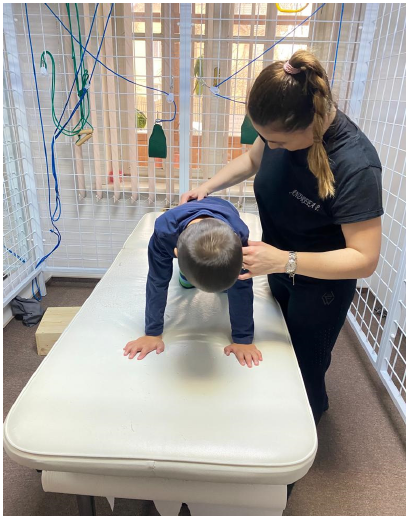
Figure 5. The exercise “Quadruped imbalances”.